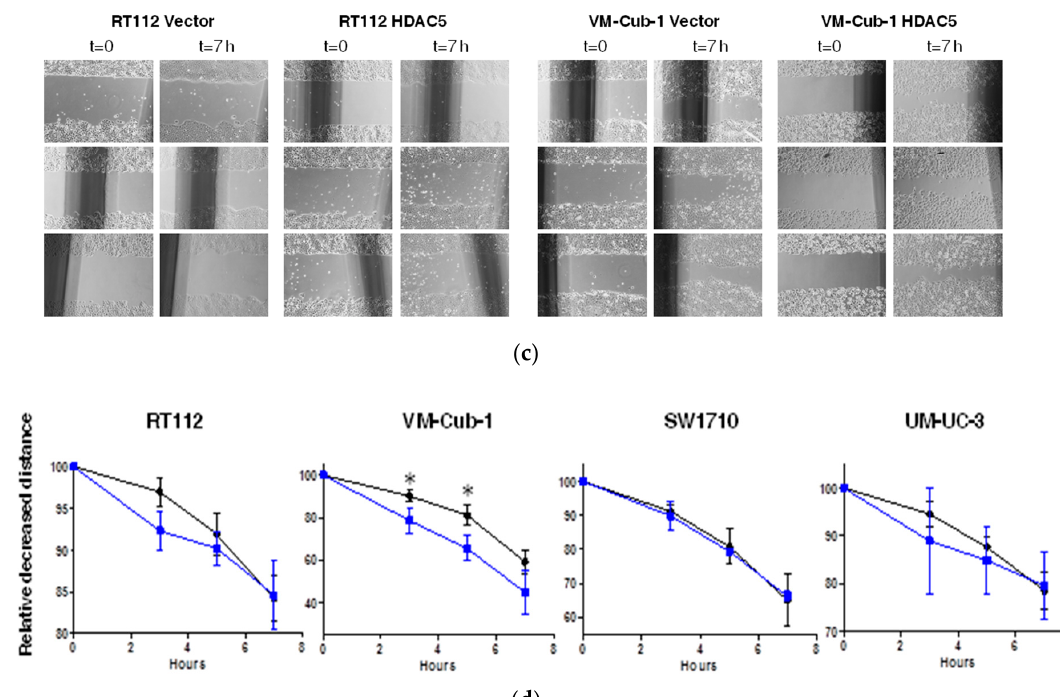
Figure 5. HDAC5 triggers an epithelial-mesenchymal transition in VM-Cub-1. ( a ) Cell morphology of VM-Cub-1 vector and HDAC-5 cells was analyzed by microscopy, images were captured at different magnifications. The scale bars are 100 µm. ( b ) Equal amount of proteins from vector and HDAC5 expressing cells were subjected to immunoblotting. Cytokeratin 5 and E-Cadherin served as an epithelial marker and Vimentin as a mesenchymal marker. “ α ” denotes “antibody. C: vector-only, + HDAC5-transduced cells. ( c ) Results of migration assays. Representative images of cells at 0 h and 7 h. ( d ) Evaluation of migration assays. The distance at 0 h of each cell line was set as “100” and the decreasing lengths between the cell fronts were additionally measured after 3, 5 and 7 h. Values represent means ± SD (error bars) of triplicates. Asterisks denote significant differences (t-test, * p < 0.05). Blue: HDAC5-transduced cells; black: vector-only cells.